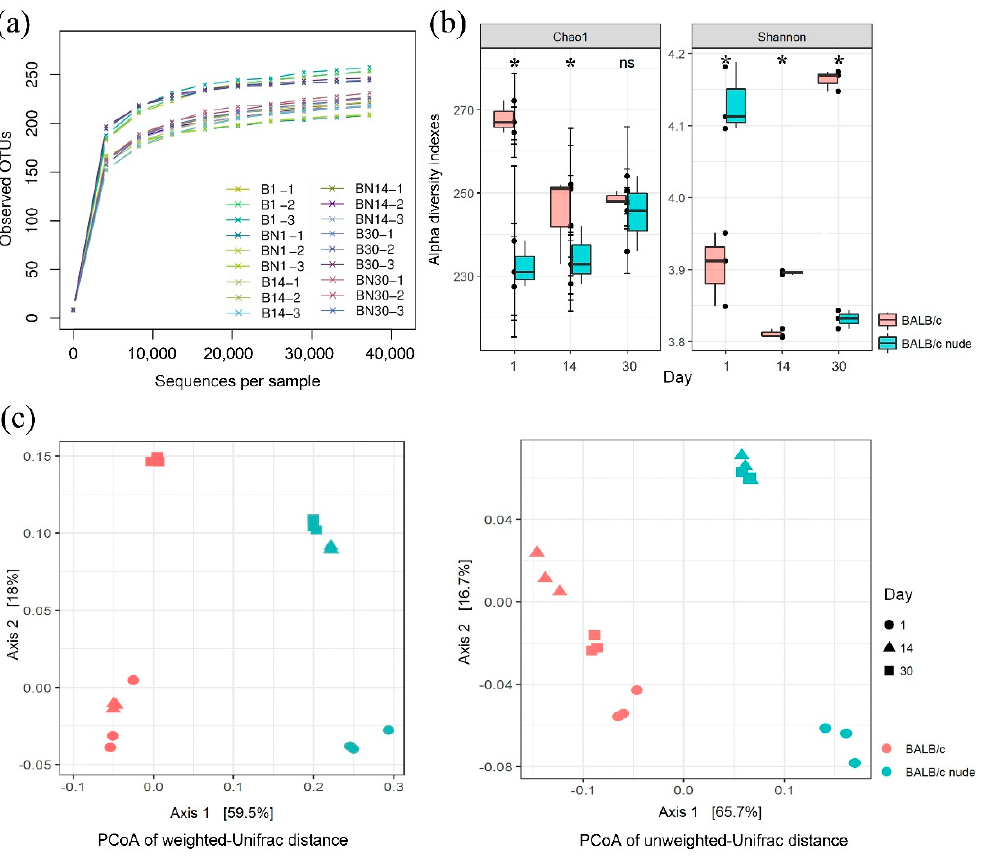
Figure 1. Gut microbial operational taxonomic units (OTUs) and diversity indexes during the development of normal and nude BALB/c pup mice. ( a ) Bacterial rarefaction curves based on observed OTUs were used to assess the depth of coverage for each sample. The samples are distinguished by different colors of lines. ( b ) Bacterial alpha diversity, as determined by the Chao1 and Shannon indexes. The asterisks show the significance determined by independent t-test, and “ns” indicates cases where the difference was not significant. ( c ) Scatterplots from principal coordinate analysis (PCoA), based on weighted and unweighted UniFrac distances of the OTUs in all samples at each of three time points.